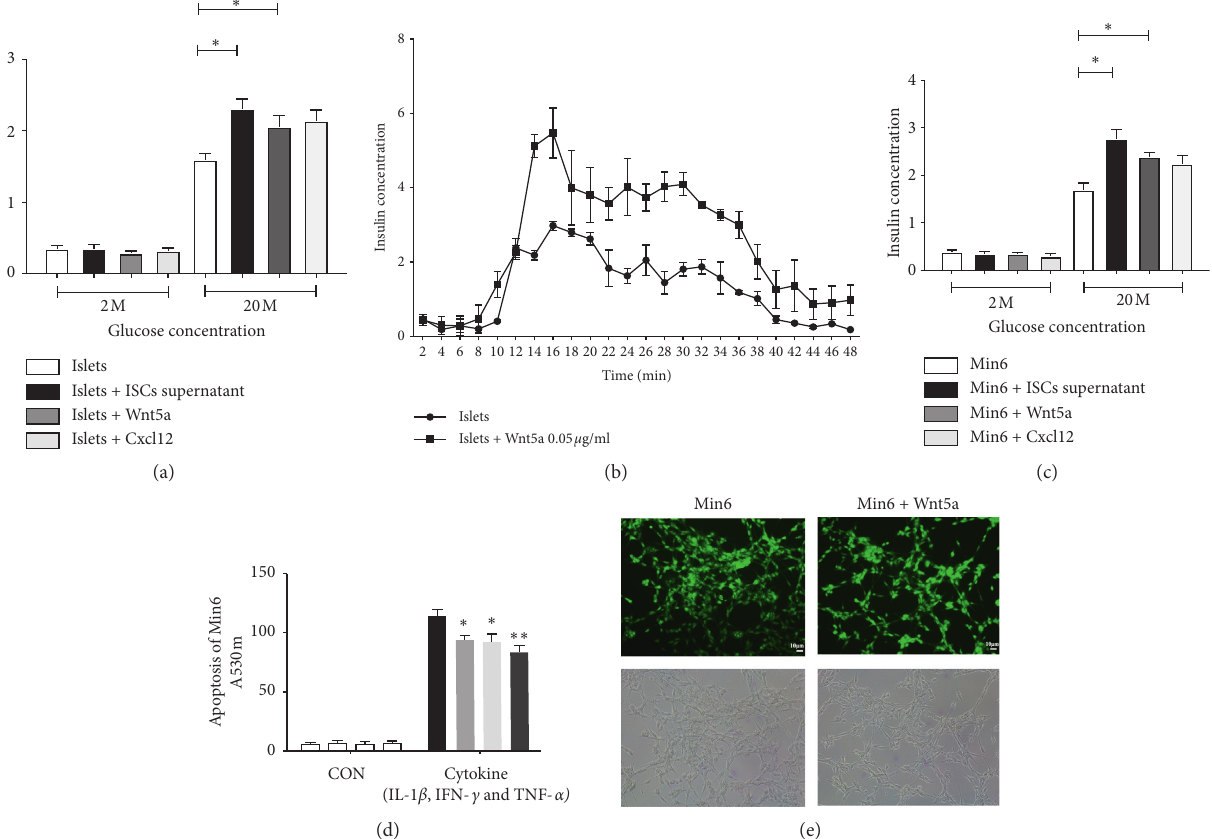
Figure 5: Wnt5a increases insulin secretion from Min6 cells. (a, b) Compared with islets cultured alone, islets cocultured with ISCs or Wnt5a exhibited significantly increased insulin secretion. The data are expressed as the mean ± SE ( n � 3); ∗ p < 0 . 05, ∗∗ p < 0 . 01, vs. islets cultured alone. (c) Compared with Min6 cells cultured alone, Min6 cells cocultured with ISCs or Wnt5a exhibited significantly increased insulin secretion. (d) Apoptosis assays of Min6 cells from the cytokine-induced and control groups. (e) Proliferation assays of Min6 cells from the cytokine-induced and control groups. The data are expressed as the means ± SE ( n � 3); ∗ p < 0 . 05, ∗∗ p < 0 . 01, vs. Min6 cells cultured alone.